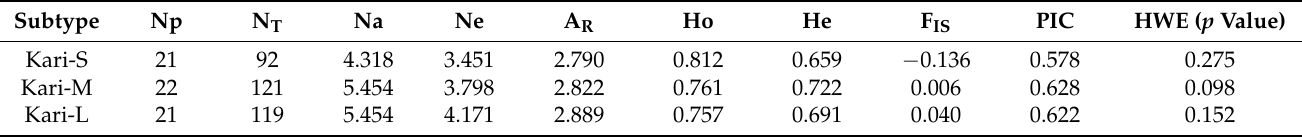
Table 2. Mean values of gene diversity overall loci in different sheep